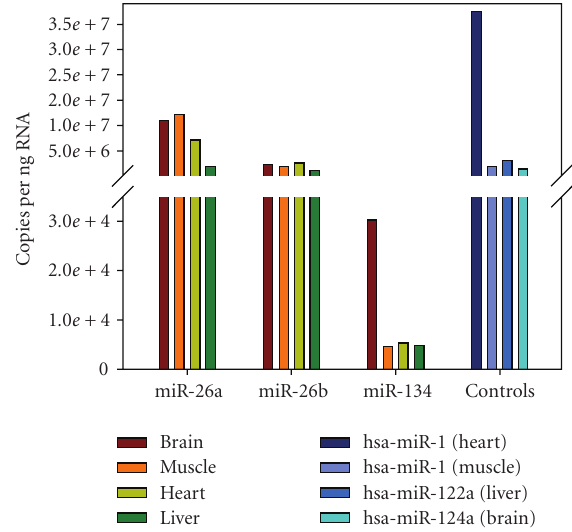
Figure 7: Expression values of hsa-miR-26a, hsa-miR-26b, and hsa- miR-134 reported in literature [13] compared with the expression values of tissue-specific